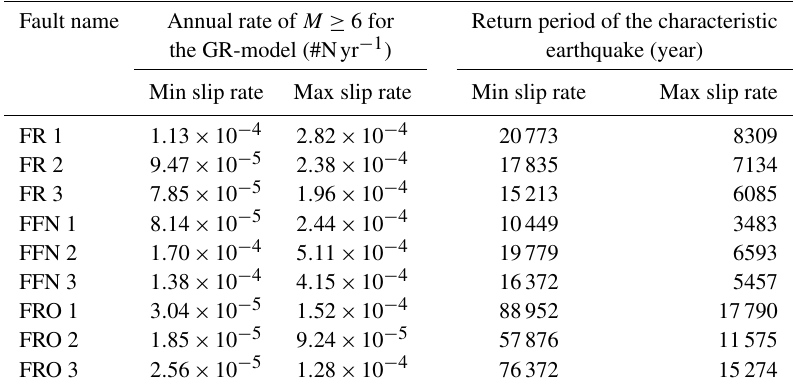
Table 2. Example of seismic activity for each fault deduced from their slip rate and geometries (Table 1, seismogenic depth of 15km, steepest dip of the faults) and µ = 3 × 10 10 Nm − 2 . FR is Rhine River fault, FFN is Black Forest fault and FRO is West Rhenish fault.